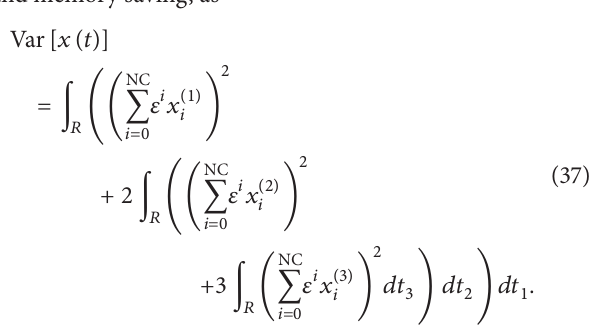
and memory saving,